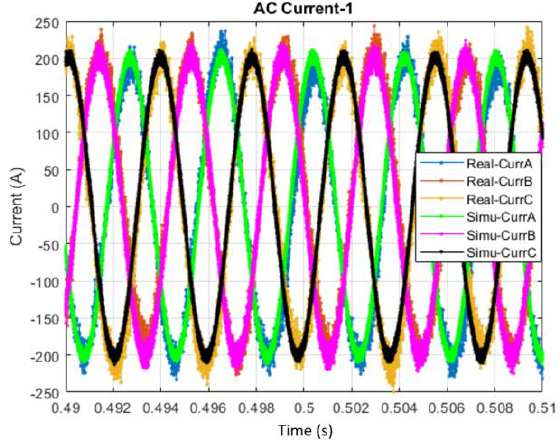
Figure 22. Case 3: speed = 7700 RPM and torque = 14 Nm.